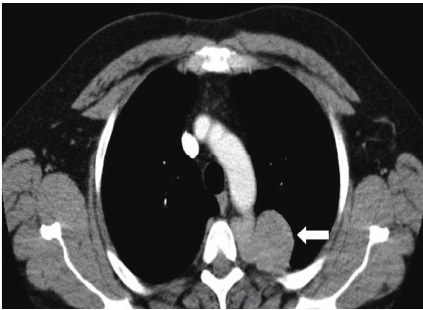
Figure 4: Chest MRI (axial T2 turbo spin echo sequence) in a 50- year-old male patient with Castleman disease. The left paraspinal pleural-based mass is heterogeneously hyperintense to skeletal muscle on T2-weighted sequences